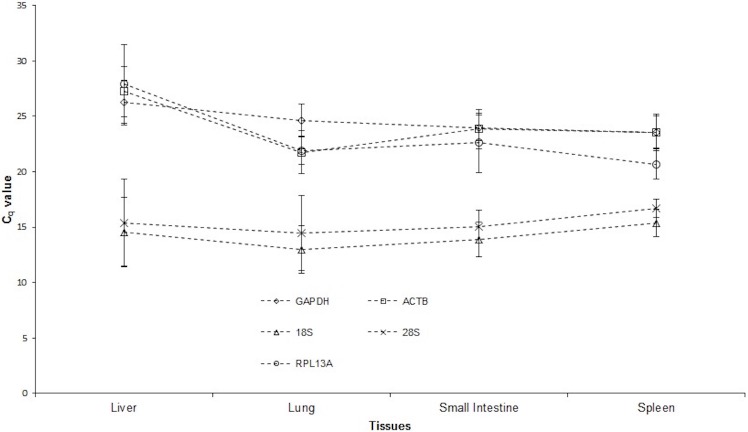
Average RNA transcription levels of putative reference genes presented as absolute Cq values.The reference genes are: Glyceraldehyde 3-phosphate dehydrogenase (GAPDH), β-actin (ACTB), 18S rRNA (18S), 28S rRNA (28S) and ribosomal protein L13a (RPL13A) in liver, lung, small intestine and spleen tissue samples.